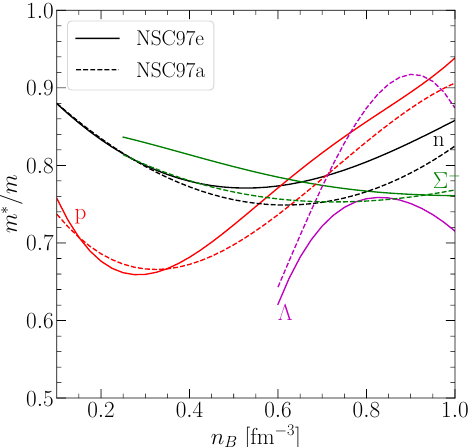
Figure 2. Effective baryon masses on the Fermi surface as a function of the total baryon number density for the NSC97e (solid lines) and NSC97a (dashed lines)